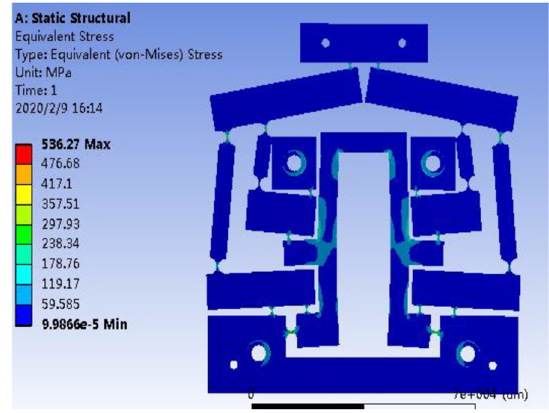
Fig. 6. Stress analysis diagram of the mechanism.